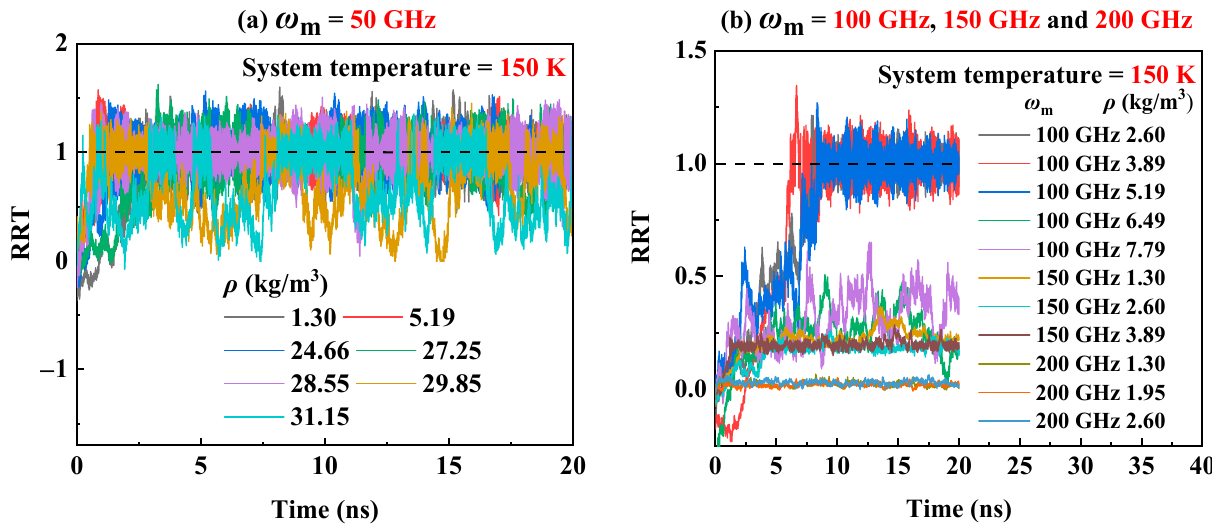
Figure 6. The curves of RRT at 150 K in a helium environment when ( a ) ω m = 50 GHz, ( b ) ω m = 100 GHz, 150 GHz, and 200 GHz.